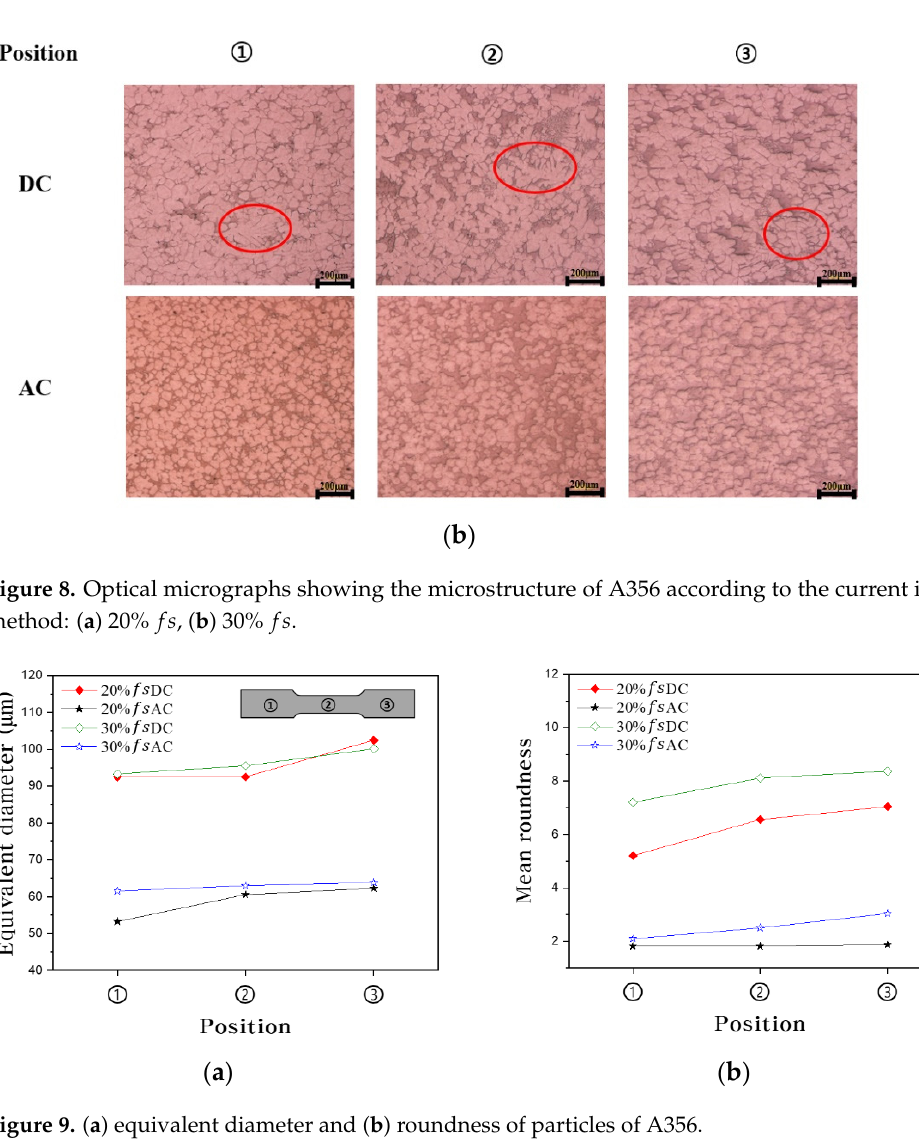
Figure 9. ( a ) equivalent diameter and ( b ) roundness of particles of A356.